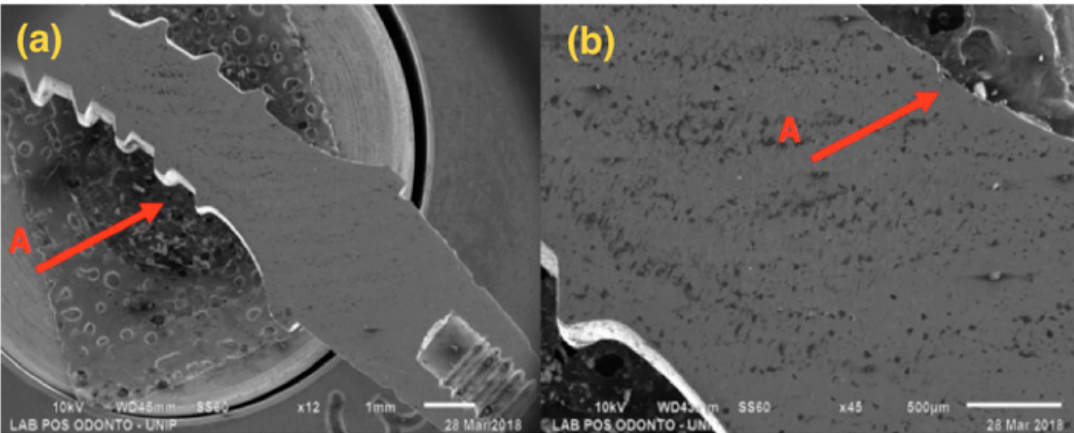
Figure 5. G2: Photomicrography: ( a ) Magnification of 12 × ; ( b ) Magnification of 45 × ; A—Distortion is